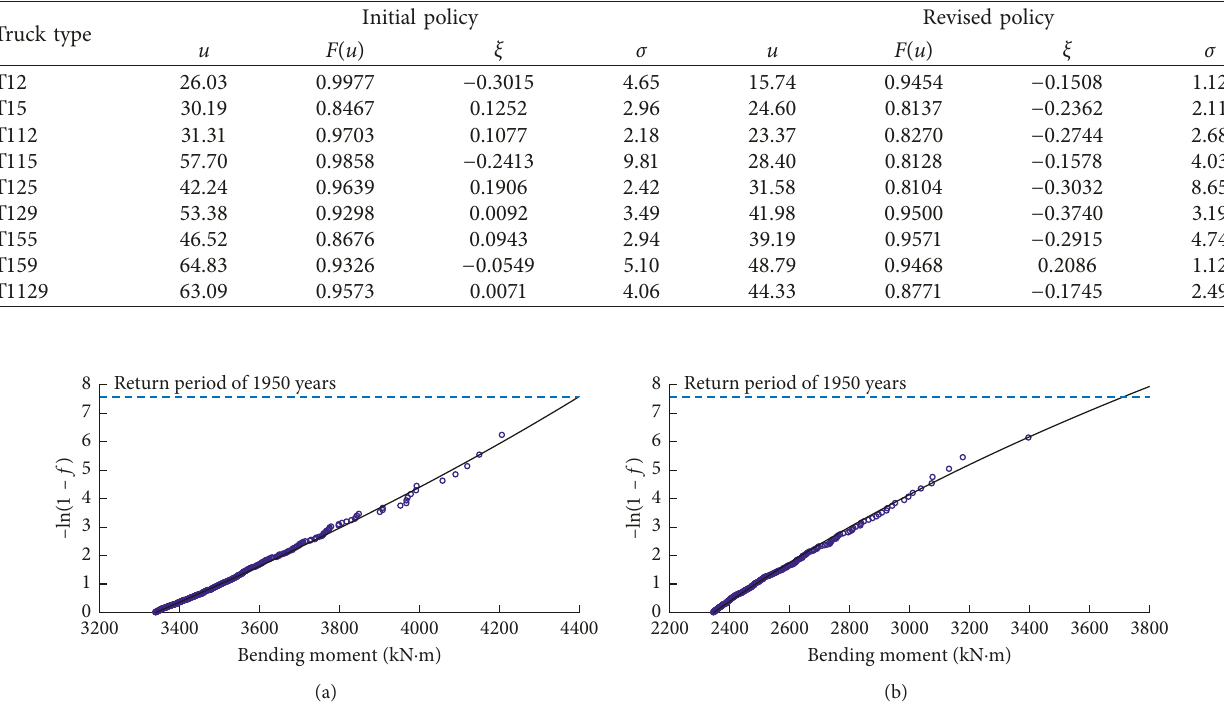
Figure 7: Extreme extrapolation of bending moment for a 20m bridge under (a) initial toll-by-weight policy and (b) revised toll-by-weight Table 10: Characteristic load effects ( S r ) under the initial and revised toll-by-weight policies and their relative values to load effects ( S d ) calculated using the design load model.